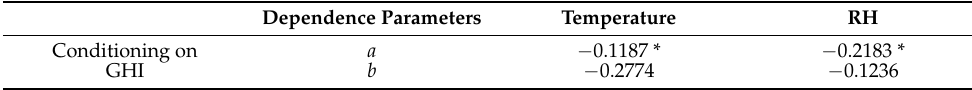
Table 5. Estimates of dependence models.